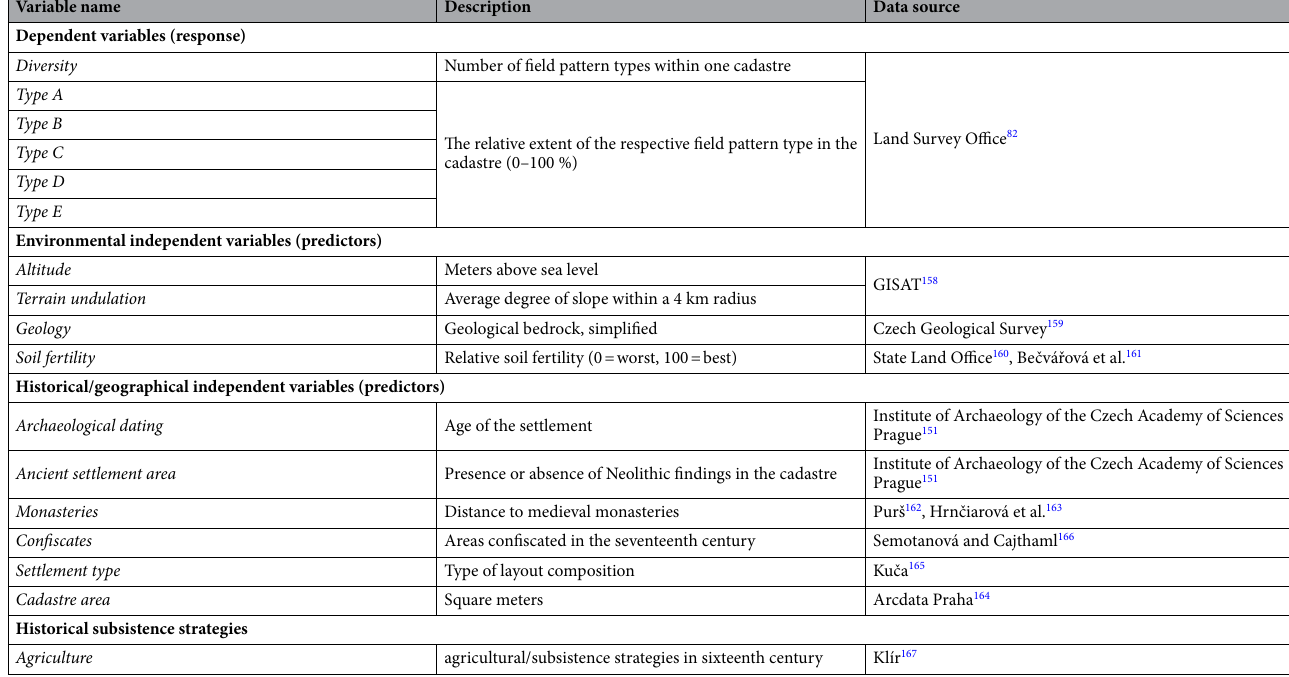
Table 1. All variables used in the study.